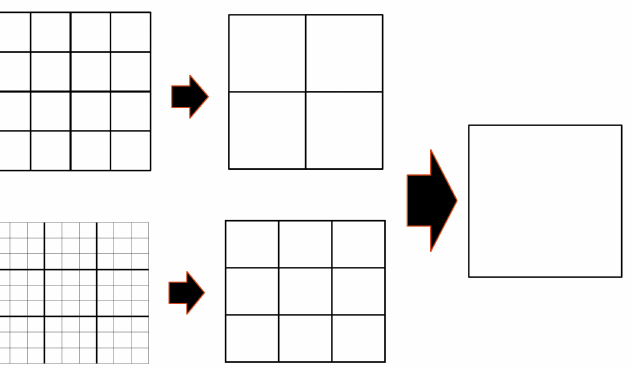
Figure 4. The hRDME approach, here represented in 2D. The mesh of 4 3 voxels ( top ) is moved to 2 3 , and then to one voxel. The mesh of 9 3 voxels ( bottom ) is moved to 3 3 and then to one voxel.